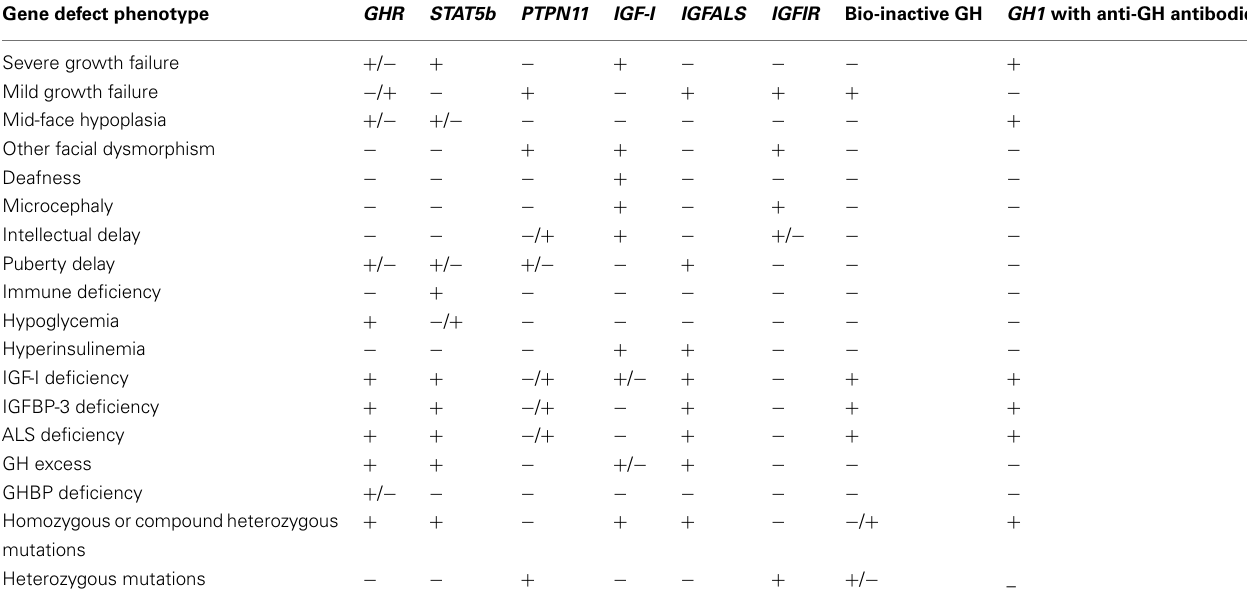
Table 2 | Summary of phenotypic and biochemical features in the range of GH–IGF-I axis